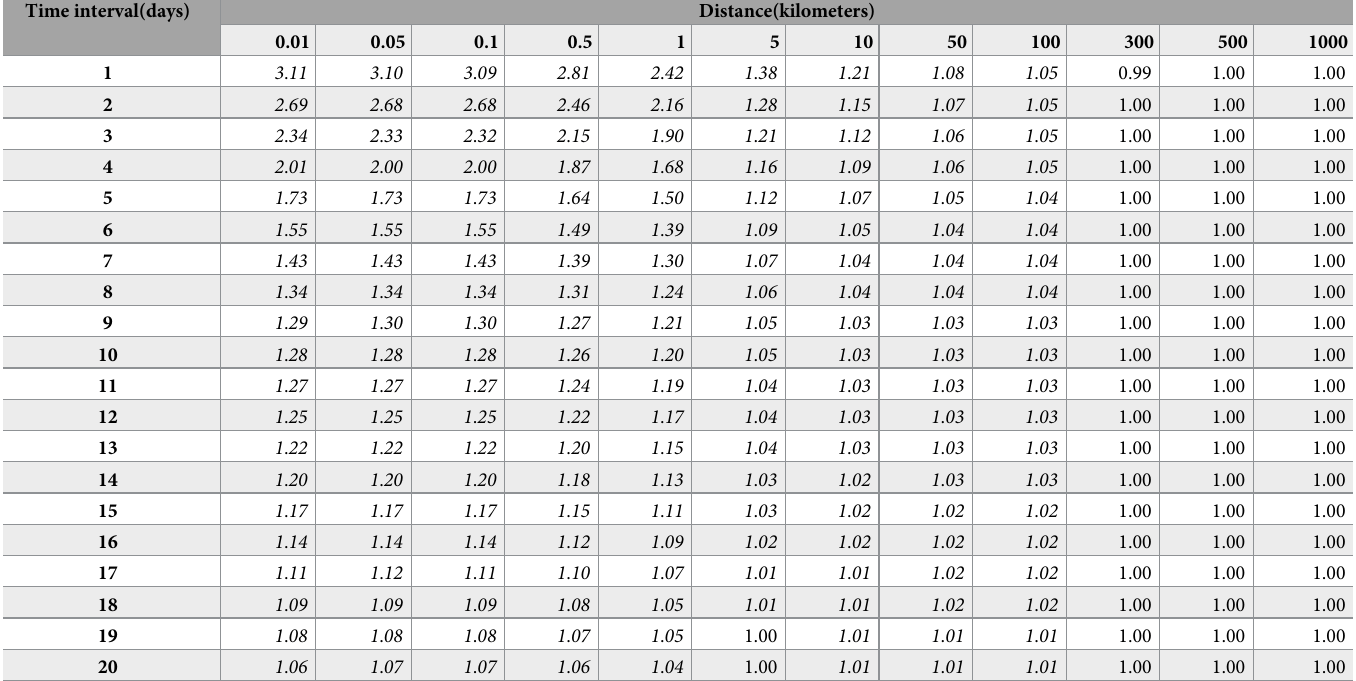
Table 1. The ER values for the epidemic of COVID-19 in Zhejiang Province using a range of distances and time intervals.